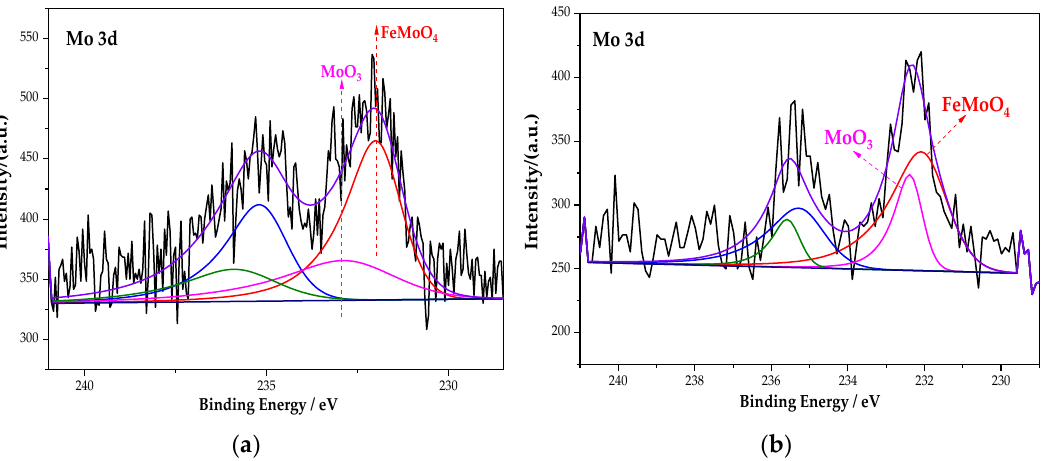
Figure 9. XPS peak spectrum of the Mo element in the passive film under the action of different rust inhibitors. ( a ) Na 2 MoO 4 group. ( b ) Na 2 MoO 4 + BTA group. Table 7. Fitting data of the Mo element in different groups.